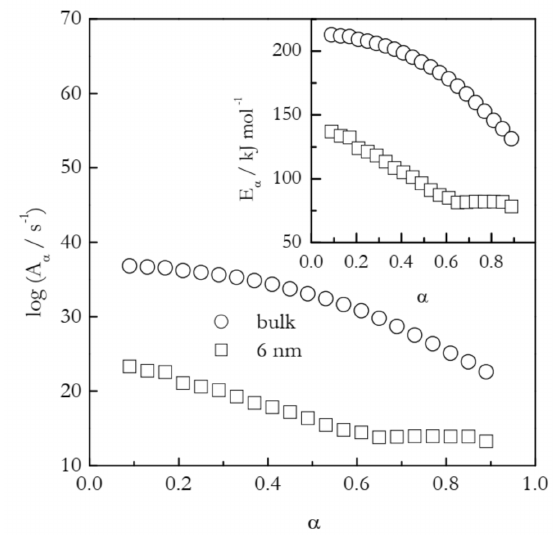
Figure 5. Isoconversional values of the activation energy and preexponential factor for melting of gelatin gel in bulk (circles) and 6 nm nanopores (squares). Adapted with permission from Prado et al. [43]. Copyright 2016 PCCP Owner